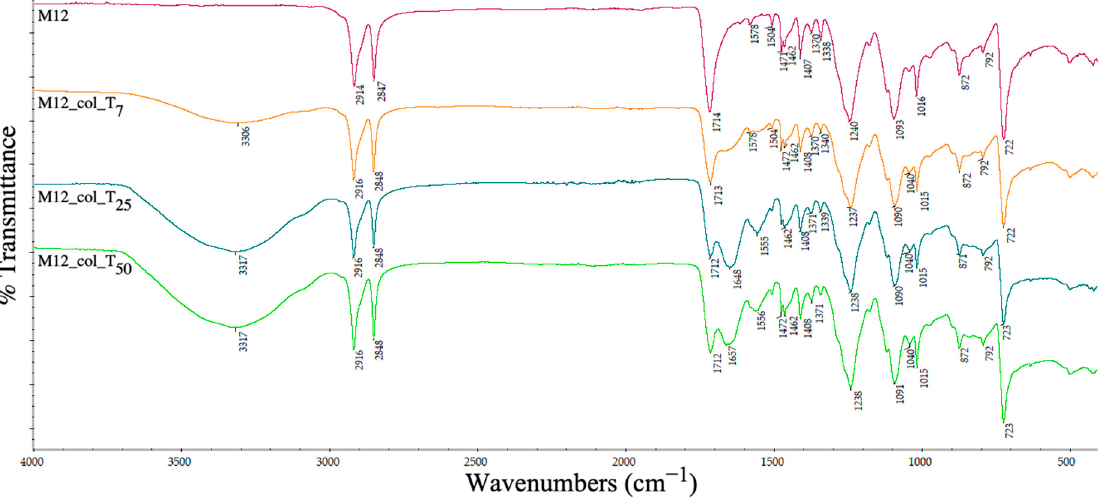
Figure 24. ATR spectra of PET–HDPE–Al nano-power composite pellets before and after collagen deposition at days 7 (T 7 ), 25 (T 25 ) and 50 (T 50 ).